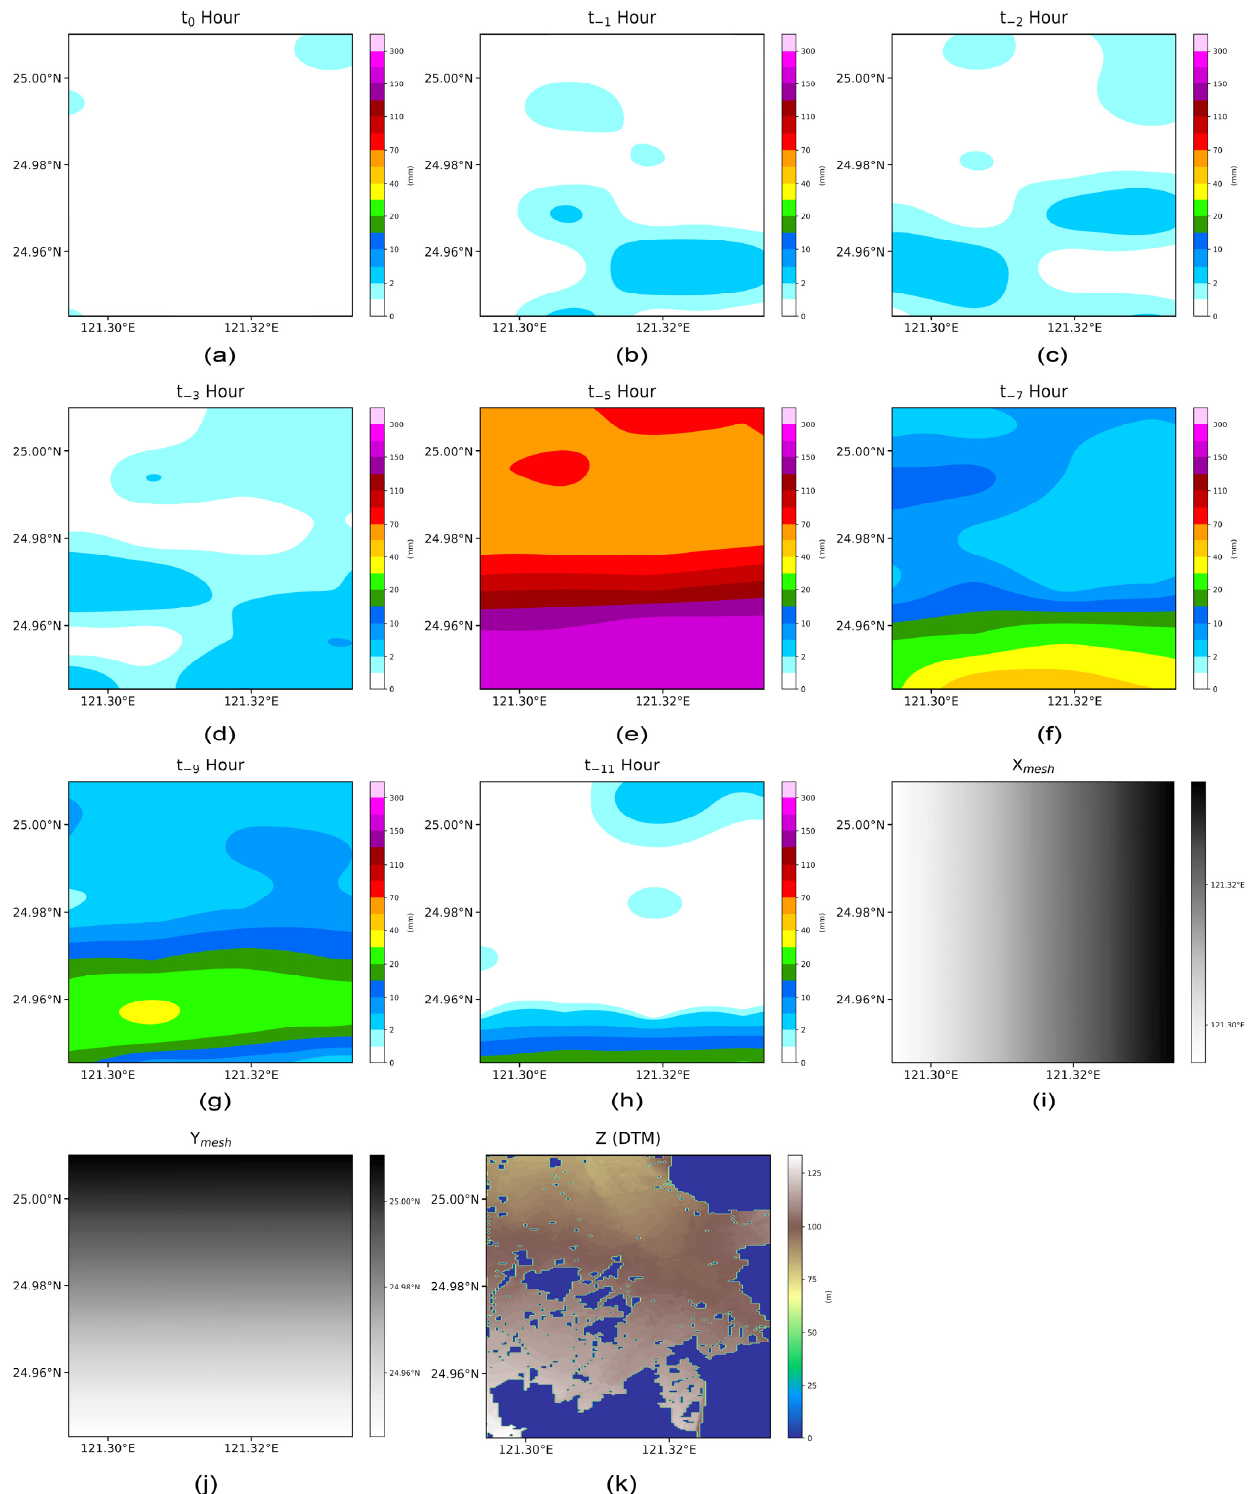
Figure 5. Schematic of the data combination, with the data being 8-h rainfall, X and Y meshes, and a digital terrain model. ( a ) the most recent hour rainfall; ( b ) the second most recent hour rainfall; ( c ) the third most recent hour; ( d ) the fourth most recent hour rainfall; ( e ) the sixth most recent hour rainfall; ( f ) the eighth most recent hour rainfall; ( g ) the tenth most recent hour rainfall; ( h ) the twelfth most recent hour; ( i ) the longitude mesh; ( j ) the latitude mesh; ( k ) elevation information.